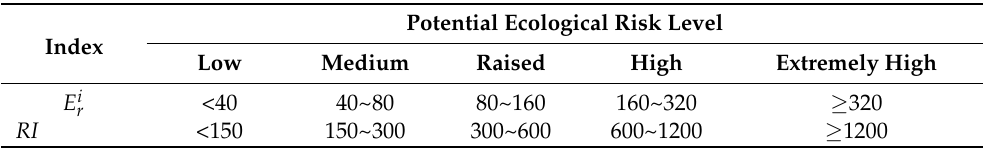
Table 1. Hakanson potential ecological hazard assessment